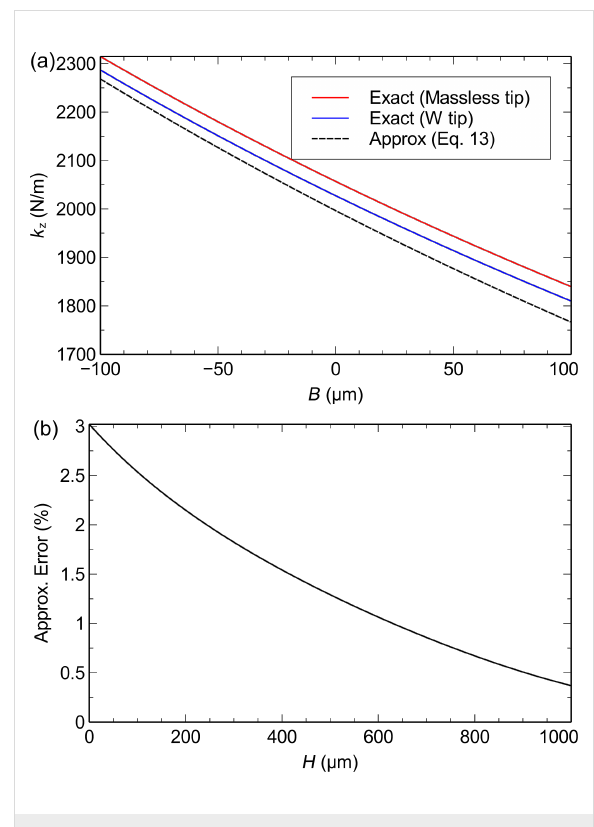
Figure 4: Theoretical prediction of the spring constant k z . (a) k z vs axial tip offset B . The spring constant is calculated with the exact expression (Equation 7) for a massless tip and for the 50 μ m tungsten wire tip with H = 400 μ m and compared to the approximate expression (Equation 8). (b) Approximation error vs H for B =